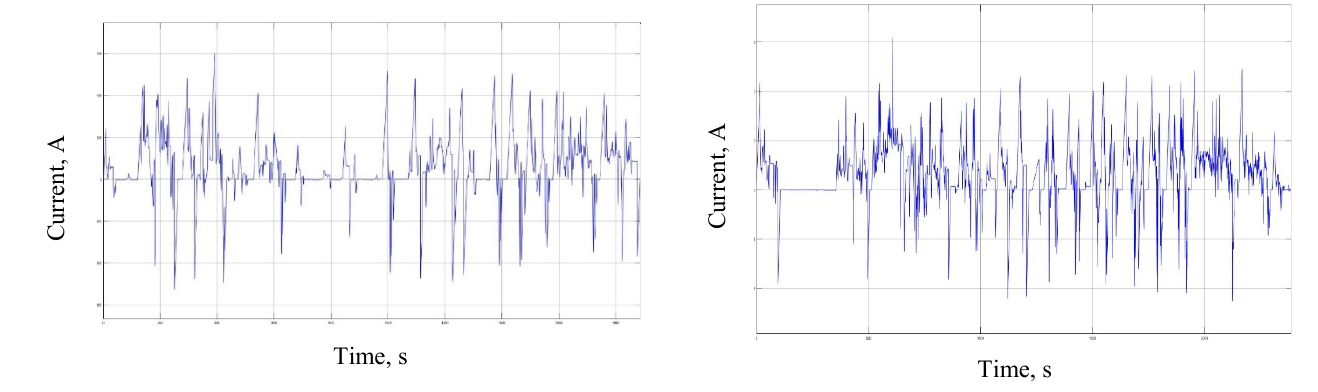
Fig. 6. Current of the accumulators calculated during modelling for both